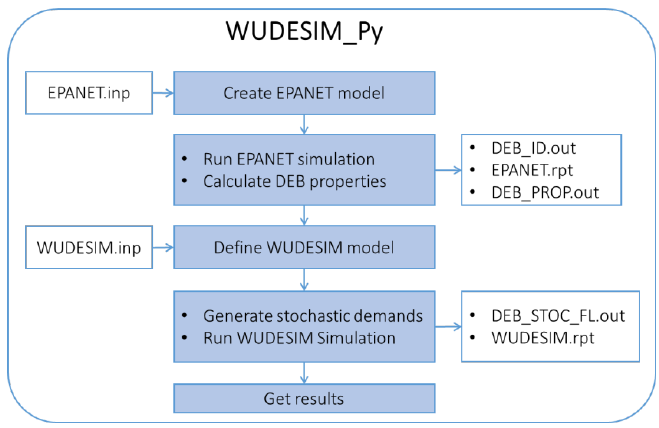
Figure 1. Overview of the WUDESIM_Py simulation procedure. Table 2. Description of Engine